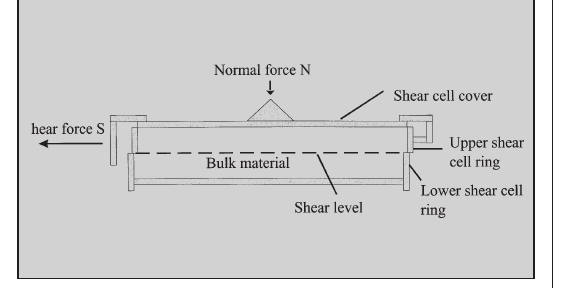
Figure 6: Translation shear cell or ”Jenike Shear